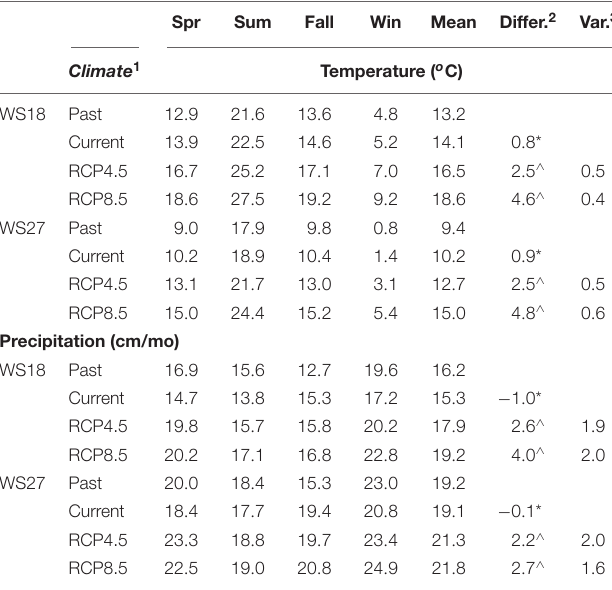
TABLE 1B | Statistical test of temperature and precipitation between current and changing climate scenarios.